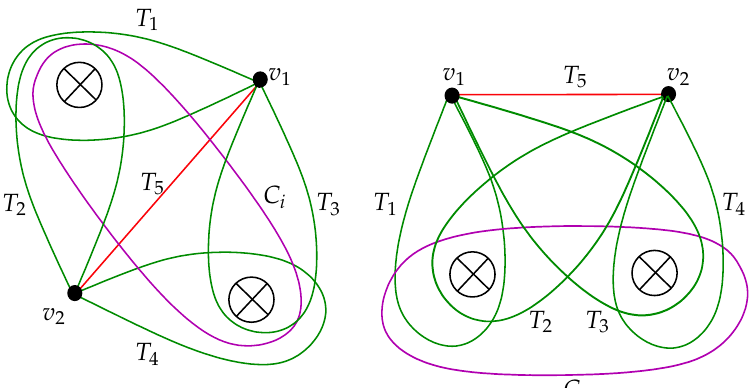
Figure 8. A clover and a